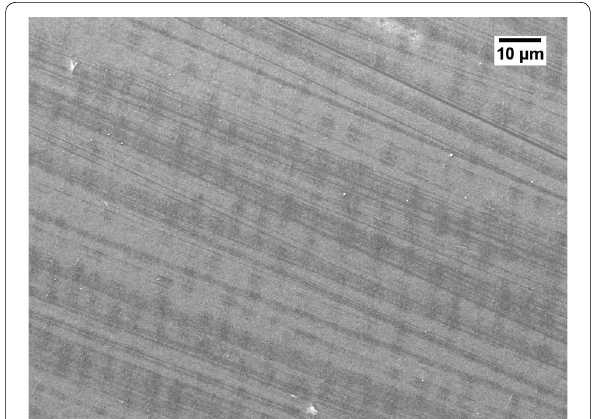
Fig. 2 SEM image of PEI membrane made by NMP and 27 wt% PEI